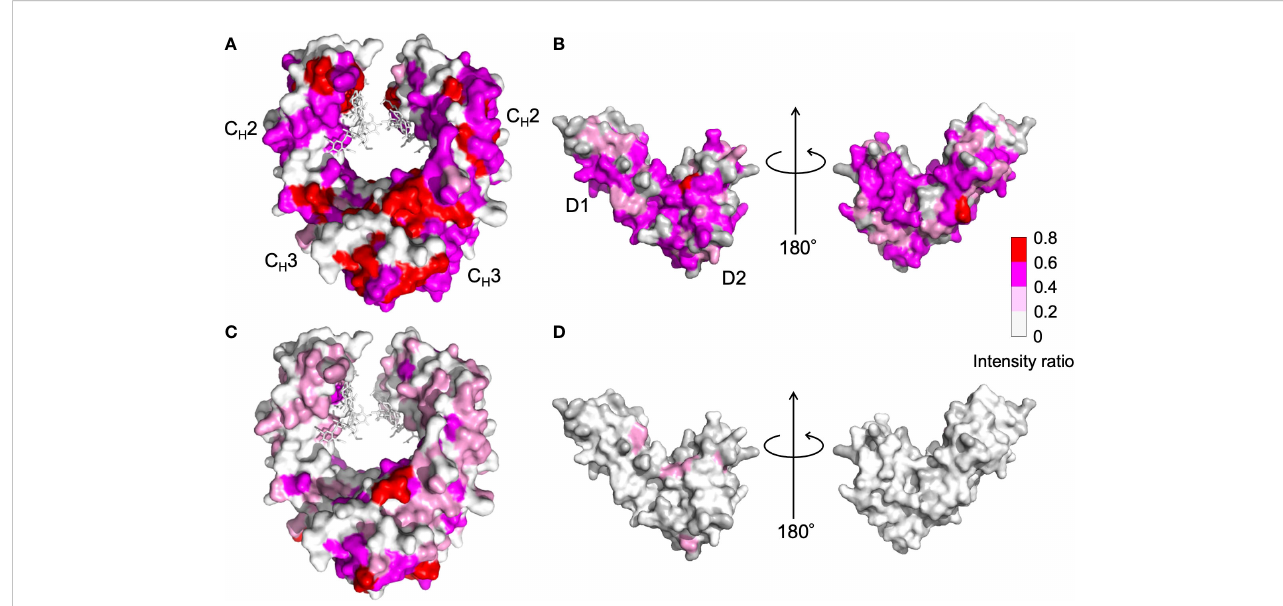
FIGURE 5 Mapping on the crystal structure of (A, C) human IgG1-Fc [PDB code: 3ave (27)] and (B, D) sFc g RIIIb [PDB code: 1T89 (28)] with the observed spectral perturbations by addition of (A, B) HSA, and (C, D) polyclonal IgG-Fab. The attenuation in intensity of the HSQC peaks originating from the backbones of human IgG1-Fc and sFc g RIIIb was calculated as ( I o- I p)/ I o, where I o and I p are original peak intensity and intensity after perturbation, respectively, and mapped on their crystal structures. The proline residues and the residues whose 1 H- 15 N HSQC peaks could not be observed as probe because of broadening and/or overlapping are shown in gray. The N-glycans of IgG1-Fc are shown as stick models. The molecular graphics were generated using PyMOL (29).